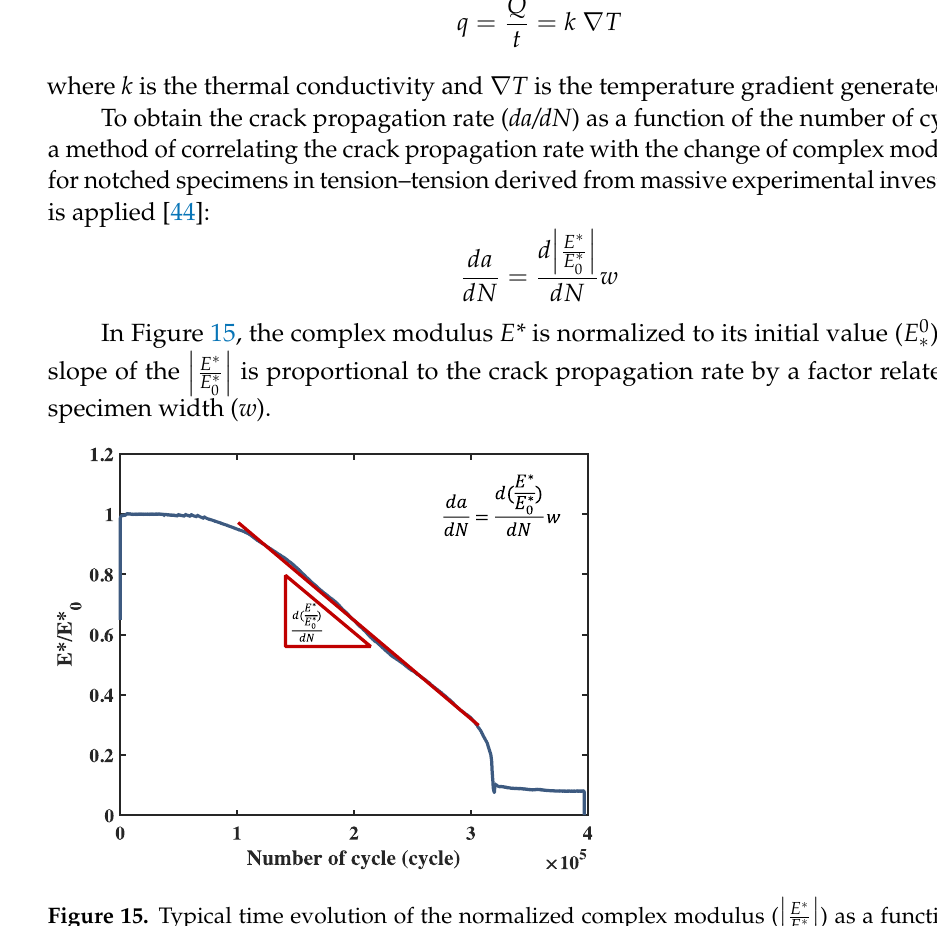
Figure 15. Typical time evolution of the normalized complex modulus ( | 𝐸 number of cycles during a fatigue test of vHDPE in tension – tension at ε 0 = 0.24%, f = 5 Hz and R = 0.3. Red line indicates the slop.